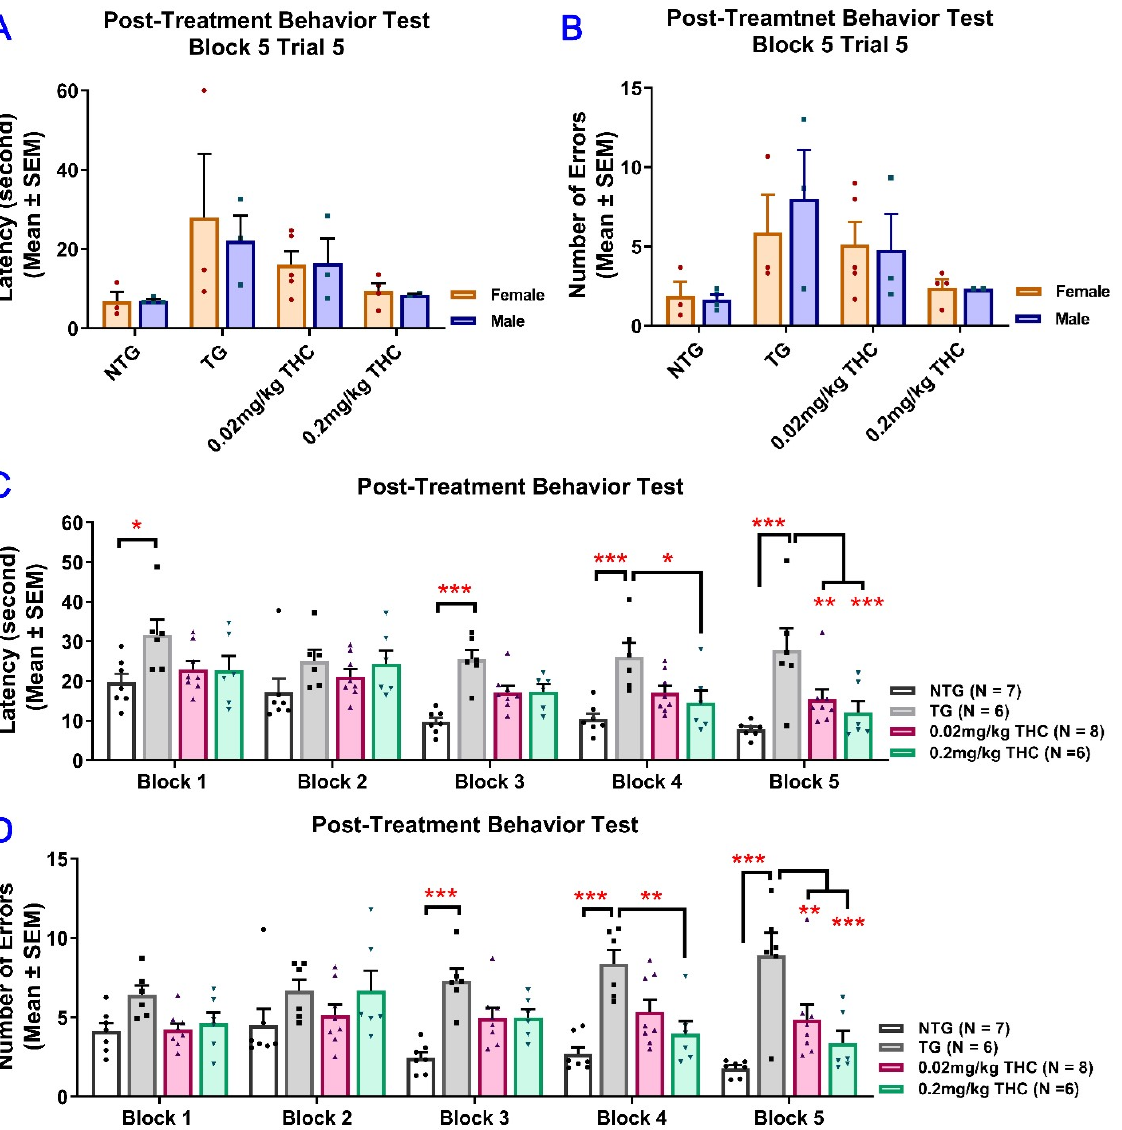
Figure 4. Evaluation of the effect of THC treatment on improving the spatial reference memory of 14-month-old APP/PS1 mice using the RAWM test. Individual mice were subjected to five trials per day for 15 consecutive days with each block containing 15 trials. ( A ) No significant difference in latency between male and female mice within individual study groups in Trial 5 of Block 5 ( p = 0.998, p = 0.996, p = 0.998, and p = 0.996 for NTG, TG, 0.02 mg/kg, and 0.2 mg/kg THC groups, re- spectively, using the Independent sample t test). ( B ) No significant difference in number of errors between male and female mice within individual study groups in Trial 5 of Block 5 ( p = 0.992, p = 0.979, p = 0.992, and p = 0.992 for NTG, TG, 0.02 mg/kg, and 0.2 mg/kg THC groups, respectively, using the Independent sample t test). ( C ) Significant decrease in the latency in NTG control ( p < 0.001), 0.02 mg/kg THC ( p < 0.01, and 0.2 mg/kg THC ( p < 0.001) groups compared with the TG control group in Block 5 Trial 5. Significant decrease in latency was also found in the NTG control ( p < 0.001) and 0.2 mg/kg THC ( p < 0.05) groups compared to the TG control group in Block 4 Trial 5. ( D ) Significant decrease in the number of errors in 0.02 mg/kg THC ( p < 0.01) and 0.2 mg/kg THC ( p < 0.001) groups compared with the TG control group in Block 5 Trial 5. Significant decrease in the number of errors was also found in the NTG control ( p < 0.001) and 0.2 mg/kg THC ( p < 0.01) groups compared with the TG control group in Block 4 Trial 5. Data are expressed as mean ± SD. SD is denoted by the error bars. Comparison of mean latency and number of errors between female and male animals in individual study groups was made by multiple t-tests with correction for multiple comparisons using the Holm–Sidak method. Comparison of mean latency and number of errors